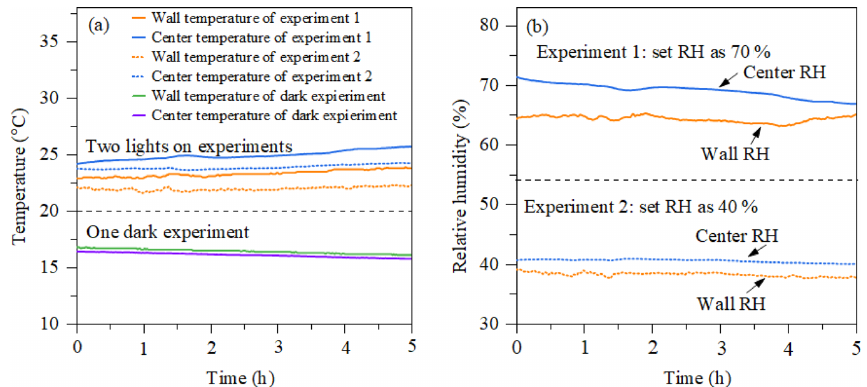
Figure 3. (a) Temperature as a function of time measured by the EdgeTech (wall temperature) and Sensirion (centre temperature) in a dark experiment and a photo-oxidation experiment. (b) RH as a function of time in the two photo-oxidation experiments.